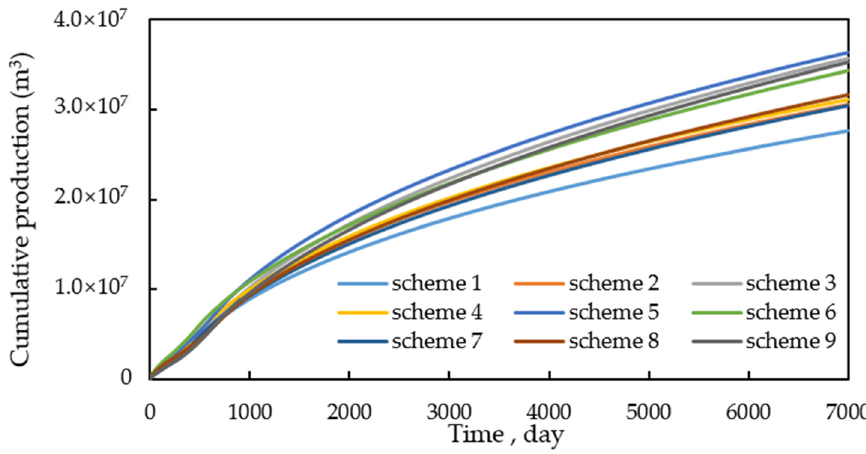
Figure 10. Horizontal well pressure distribution field diagram after different development schemes.( a ) scheme 1; ( b ) scheme 2; ( c ) scheme 3; ( d ) scheme 4; ( e ) scheme 5; ( f ) scheme 6; ( g ) scheme 7; ( h ) scheme 8; ( i ) scheme 9.